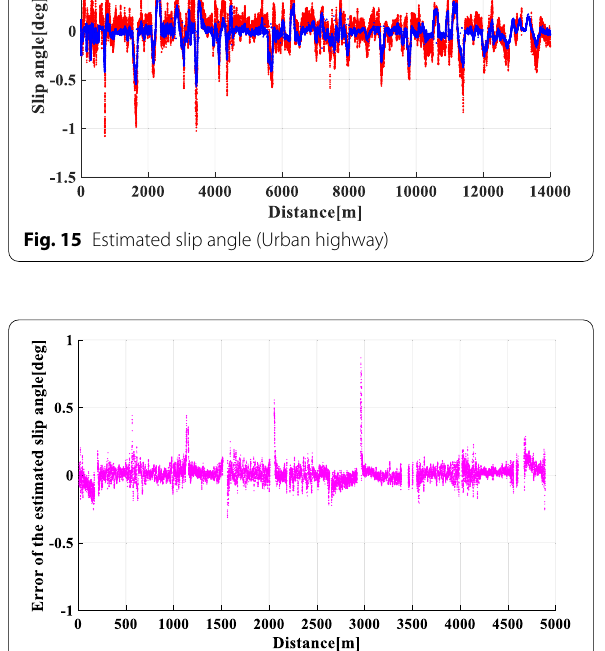
Fig. 16 Error of estimated slip angle (Urban street)